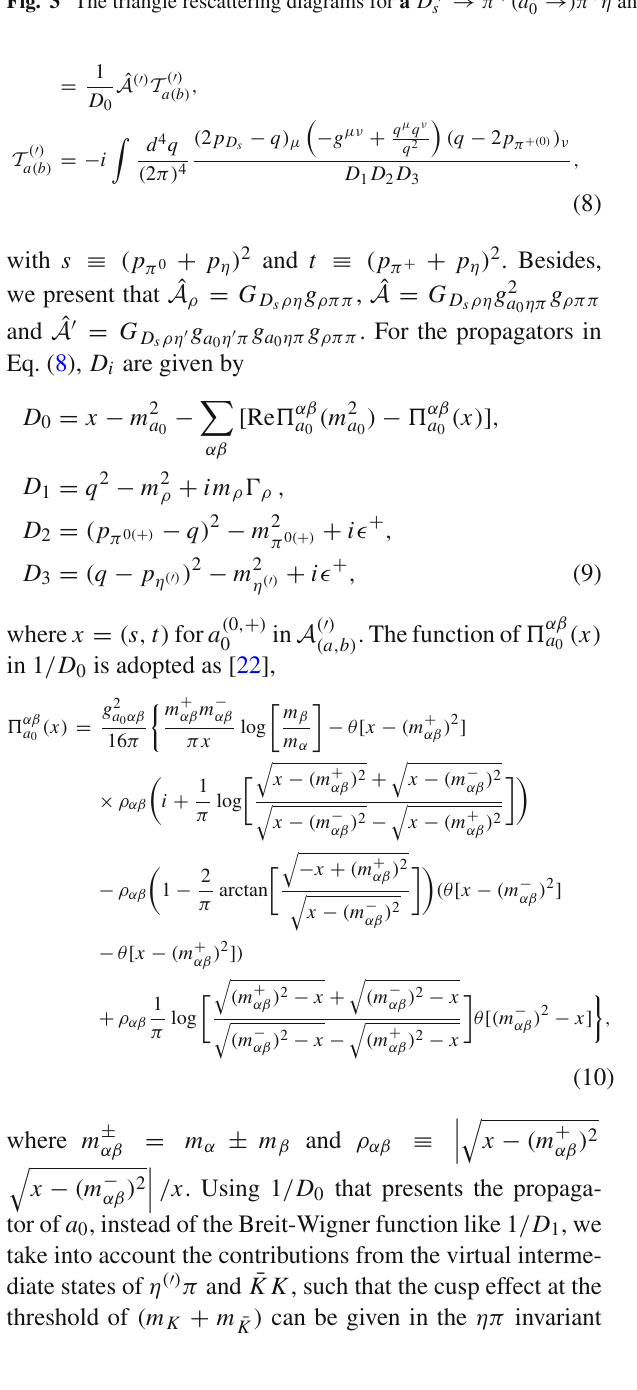
Fig. 3 The triangle rescattering diagrams for a D + s → π + ( a 0